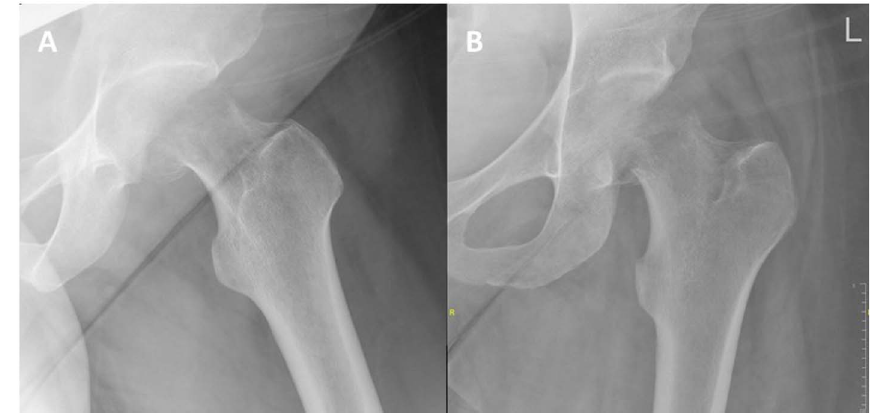
Figure 2. Lateral (A) and anteroposterior (B) radiographs of the left hip show a displaced sub-capital femoral neck